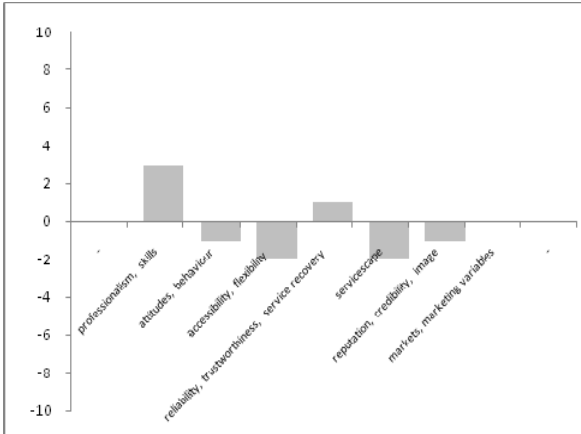
Figure 7: The underlying drivers of consumption in Factor 4